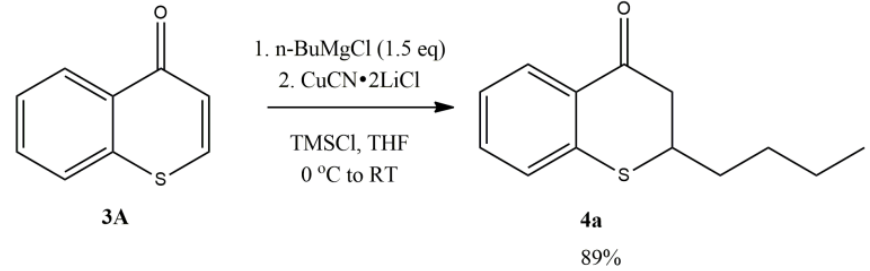
Figure 4. Copper-Catalyzed Conjugate Addition of n -BuMgCl to Thiochromones. With this optimal reaction condition found, the scope of Grignard reagents was then in- vestigated. A broad scope of Grignard reagents added to thiochromone 3A to in 1,4-additon fashion to afford 1,4-adducts 4a – h with good chemical yields (Figure 5, 64–88%). Simple Grignard reagents underwent 1,4-conjugate addition to thiochromone 3A smoothly to de- liver 1,4-adducts 4a – 4d with excellent efficiency (Figure 5, 75–88%). Steric bulkier Grignard reagents were less reactive and afford lower yields presumably due to steric hindrance (Figure 5, 4e , 69% and 4f , 64%). Grignard reagents prepared from corresponding cyclic halides also worked well (Figure 5, 4g , 82% and 4h , 85%) [58].